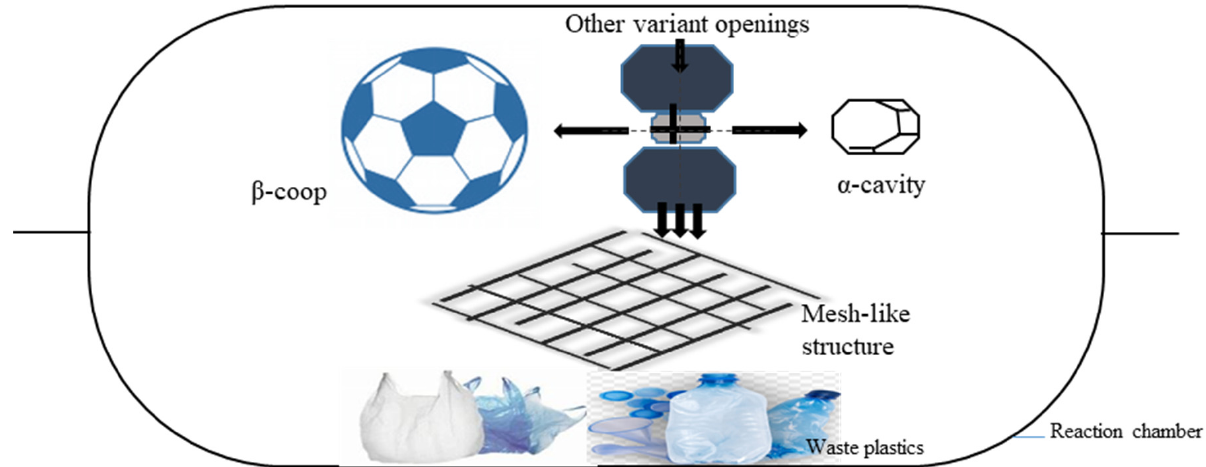
Figure 5. Structural framework of zeolite catalysts on waste plastics in a pyrolysis reactor.